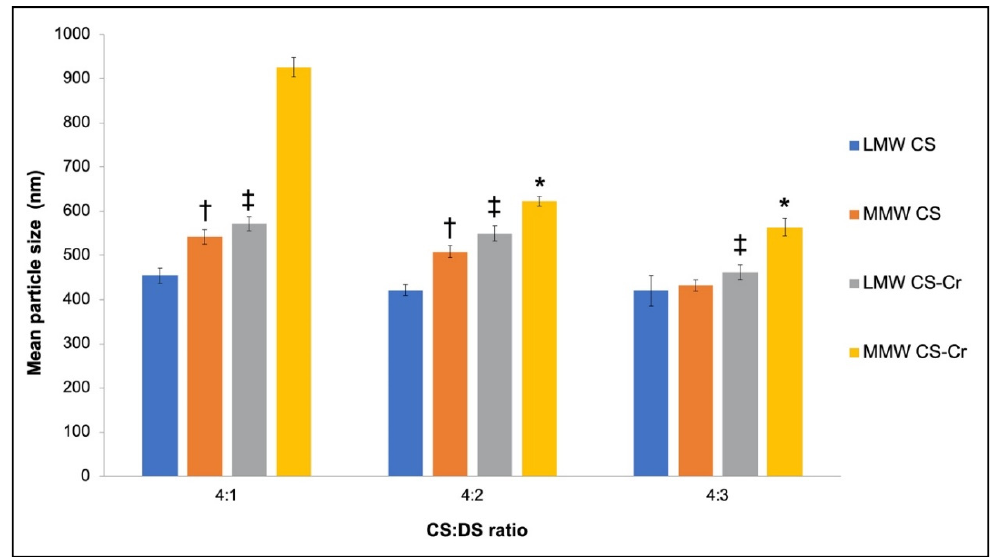
Figure 2. Particle size of empty and chromium-entrapped CS-DS nanoparticles when using different MWs of chitosan at various CS:DS ratios. Results are shown as mean ± standard deviation (SD) (n = 10). Data were considered statistically different when p < 0.05. * indicates significant difference comparing 4:1 medium molecular weight (MMW) CS-Cr to MMW CS-Cr at other ratios, † indicates a significant difference between low molecular weight (LMW) CS and MMW CS at the same ratio, ‡ indicates a significant difference between LMW CS and LMW CS-Cr at the same ratio.